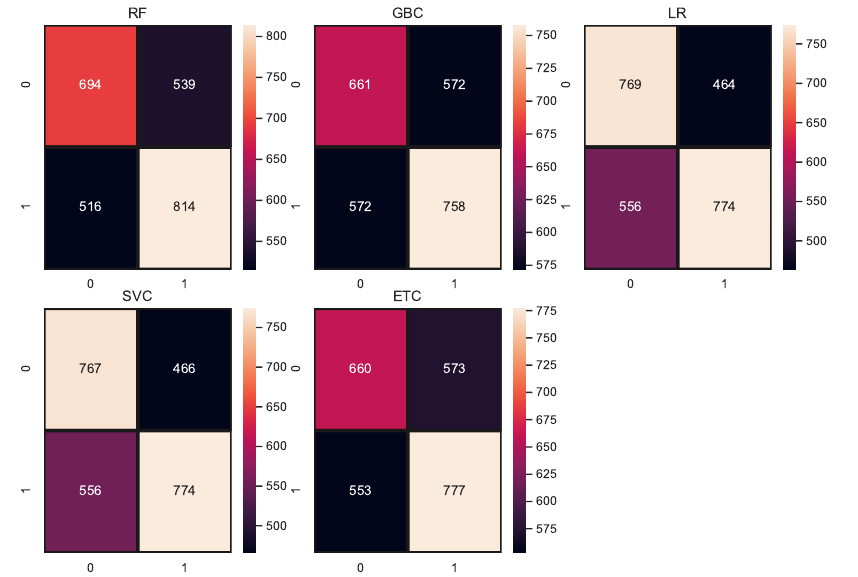
Figure 4. Cofusion matrices of all models using LR and SVM extracted